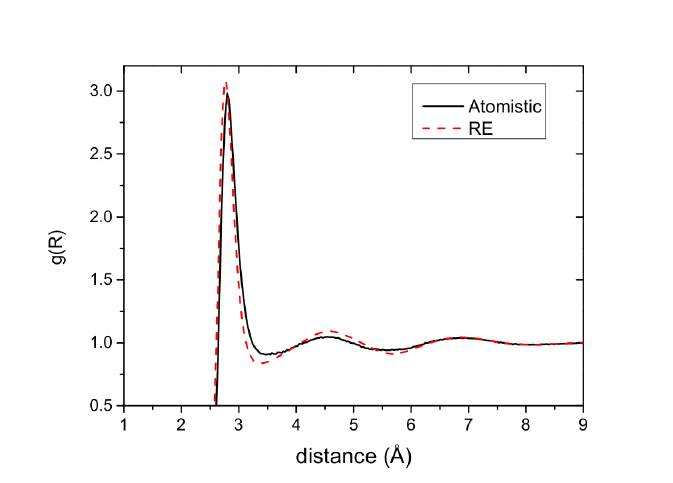
Figure 3. Water : RE derived potential reproduces well the target pair correlation.